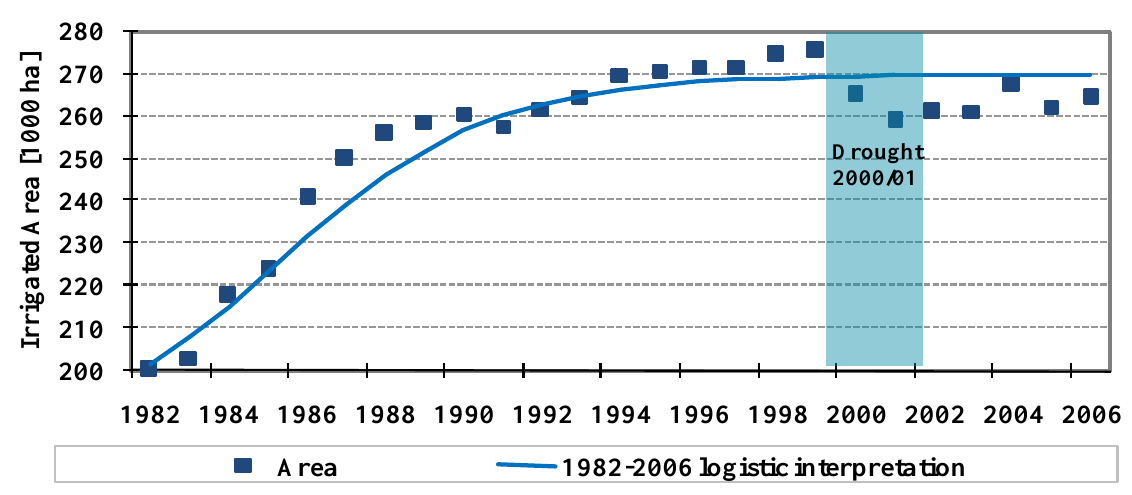
Figure 1. Dynamics of the irrigated area in Khorezm (1982−2006).